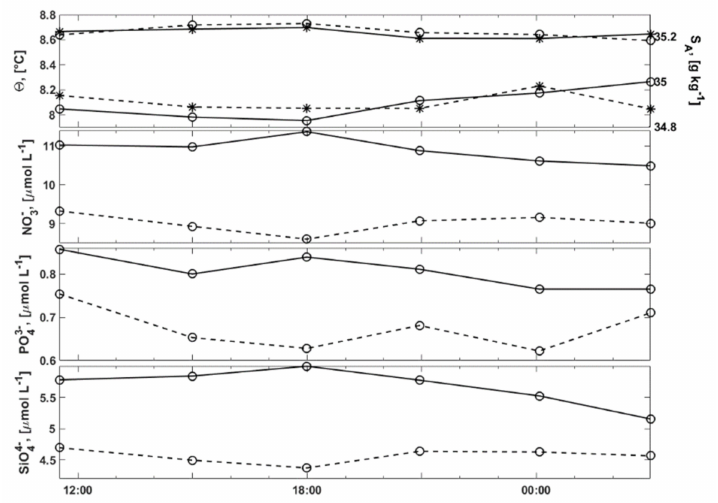
Figure 8. Short time series (x-axes) of inorganic nutrient fluctuations on 3–4 January 2017 at Nakken bank reef at 200 m (solid line) and 100 m (dashed line) depth for (first row) temperature, Θ (o) and salinity, S A (*), (secondrow)nitrate, NO 3 − , (thirdrow)phosphate, PO 43 − , and(fourthrow)silicate,SiO 44 −